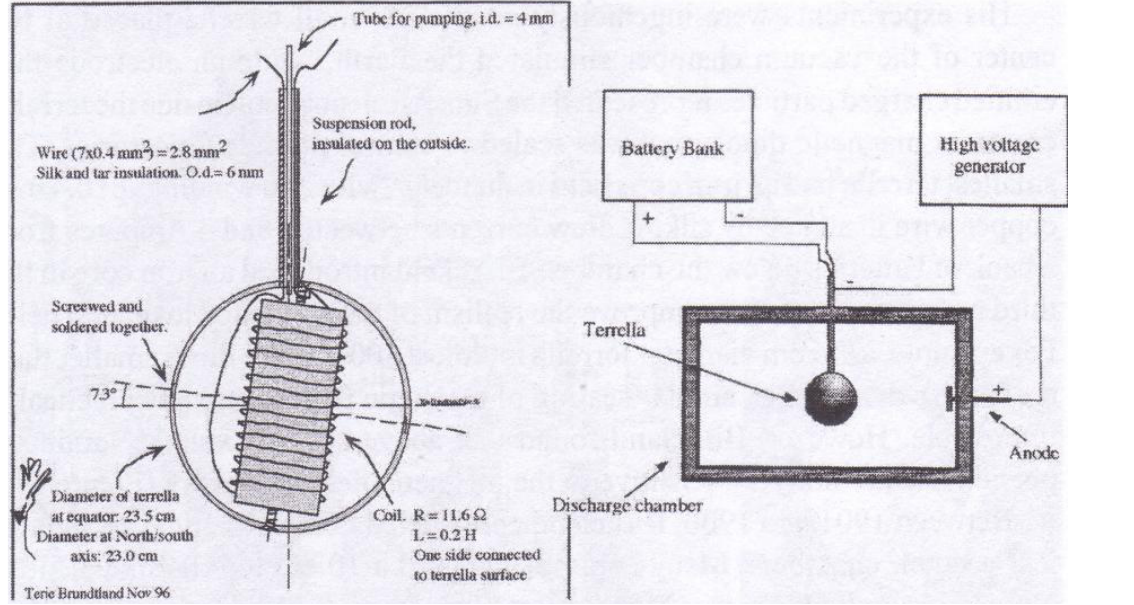
Figure 2. Schematics showing the principles underlying terrella experiments. Brundtland (1997) provides detailed technical drawings show- ing the terrella and the vacuum chamber to illustrate how dipolar magnetic fields were produced. 155 of the G¨ottingen Magnetic Union at stations around